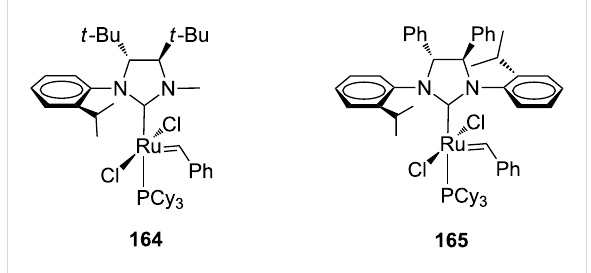
Figure 30: Grubbs-type C 1 -symmetric ( 164 ) and C 2 -symmetric ( 165 ) catalysts with a backbone-substituted NHC.